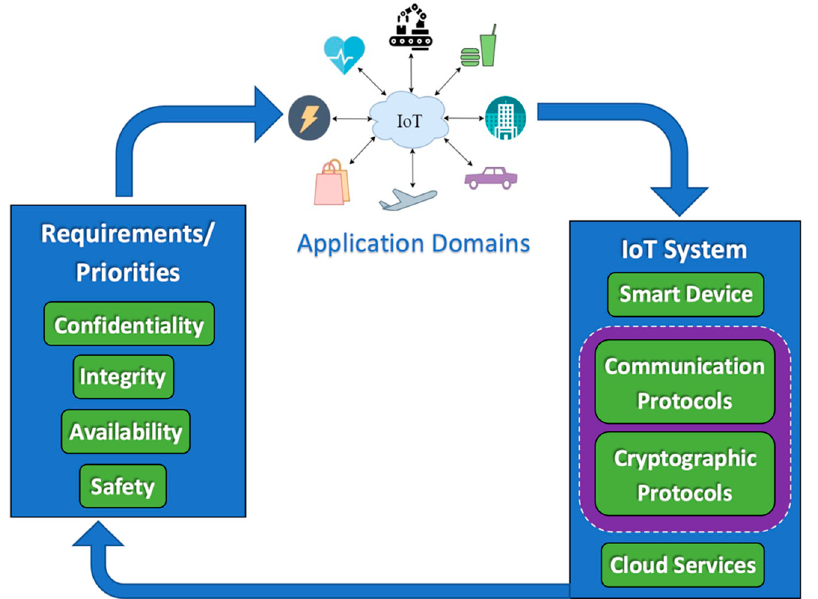
Figure 1. IoT applications have different requirements in terms of the CIA triad, in addition to safety. They should be considered when choosing the communication and security